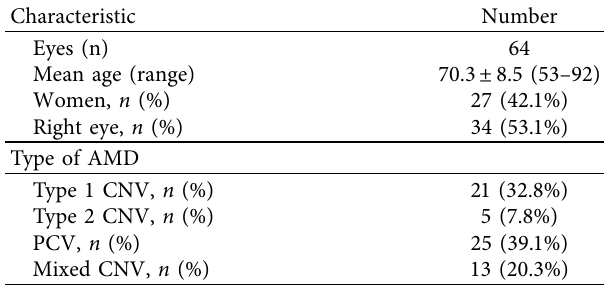
Table 1: Patient demographic and baseline